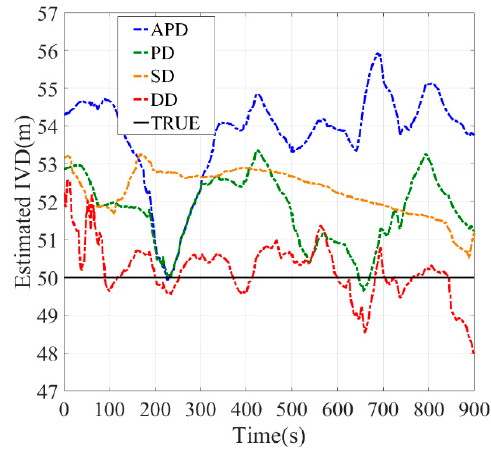
Figure 15. Baseline = 50 m. Table 2. The RMSE for different methods in the static experiment. Ture